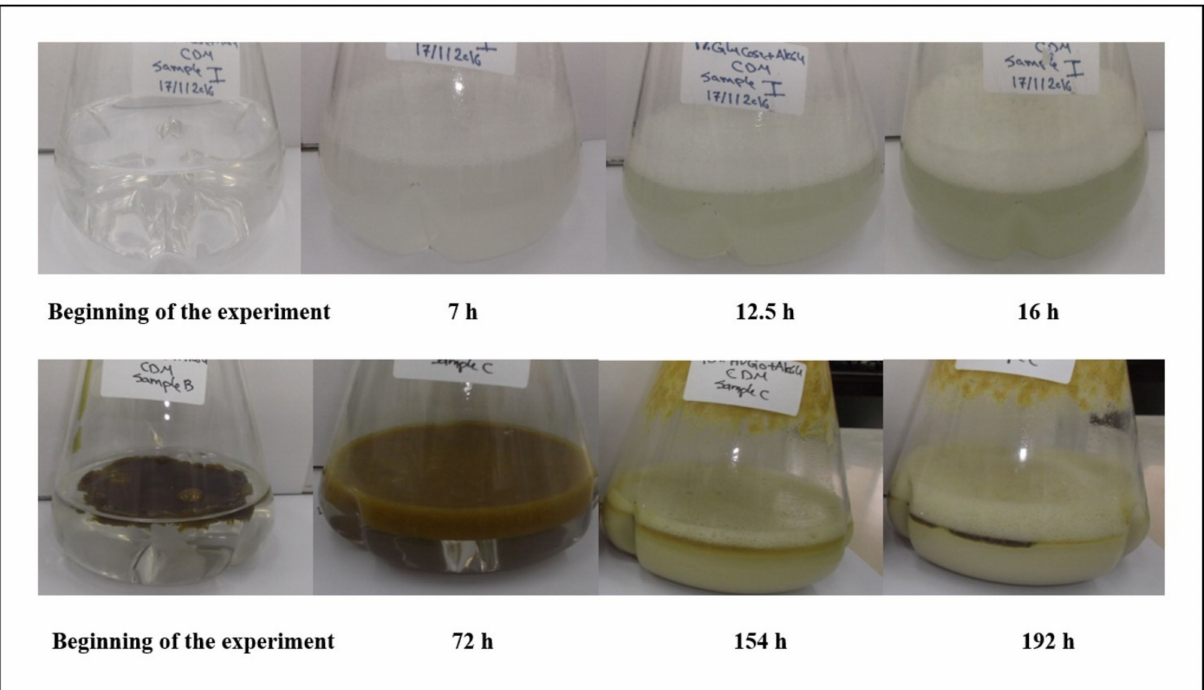
Figure 1. Growth of the strain AK6U on glucose and HVGO. The strain AK6U was cultured in chemically defined medium (CDM) containing either glucose (10 mM, upper panel) or HVGO (10% vol/vol, lower panel) as a sole carbon and energy